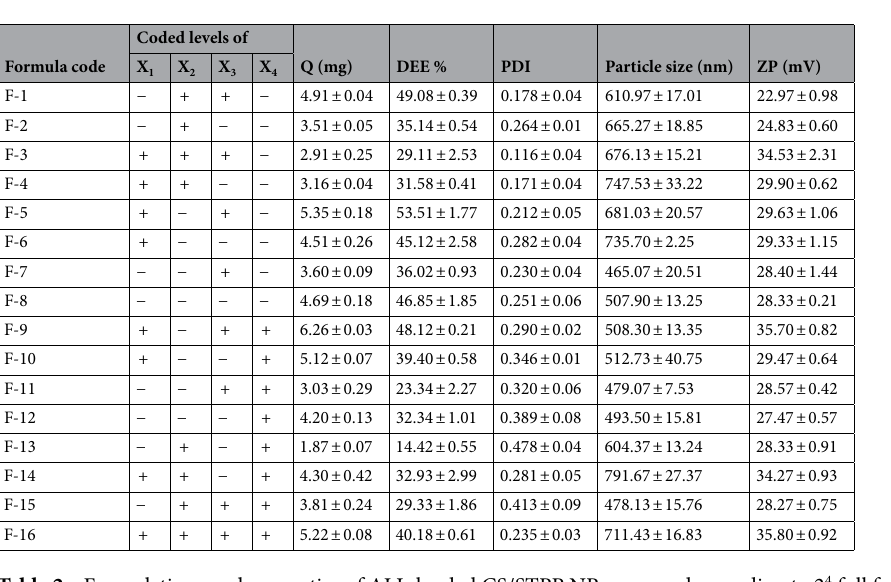
Design of experiment (DoE). DoE was challenged as an organized and structured technique for opti- mizing the ionotropic gelation method. It provides very accurate as well as precise analysis for the interactions between the input factors affecting the output responses, through the establishment of mathematical models 17 . Fully crossed design (2 4 ), as an experimental approach, allows the investigation of the individual effects and interactions of ICPs namely; CS concentration (X 1 ), STPP concentration (X 2 ), CS:STPP volume ratio (X 3 ) and ALL amount (X 4 ) on different DMPs such as Q, DEE %, particle size and ZP of ALL-loaded CS/STPP NPs. Two levels for each of the four ICPs were experimented and symbolized by the coded factor levels as + 1 (high levels) and − 1 (low levels) as presented in Table 1. Such levels were chosen based on preliminary studies and the optimi- zation procedure was established within these domains. Three replicates were conducted for each combination, total number of sixteen formulations, to prepare ALL-loaded CS/STPP NPs (Table 2). The complete polynomial regression equation was created as follows "Eq. (1)":